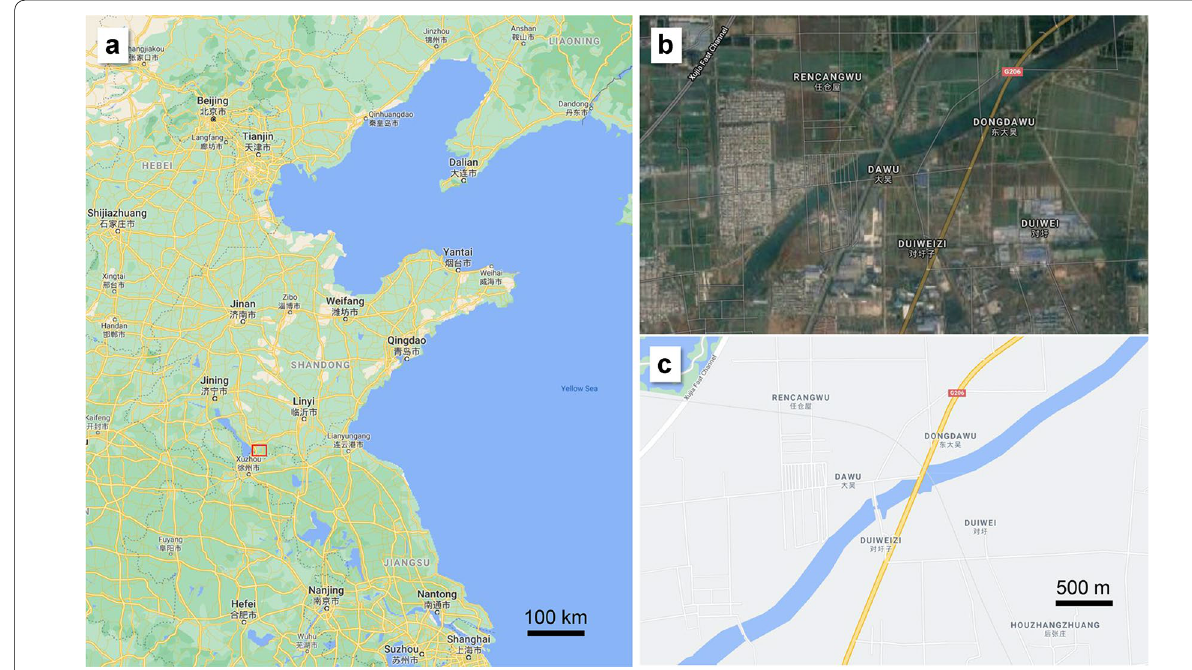
Fig. 1 a Map of Eastern China, showing the location of the study area (in red rectangle); b Satellite image and c map of the Dawu mining district. All satellite image and maps from Google